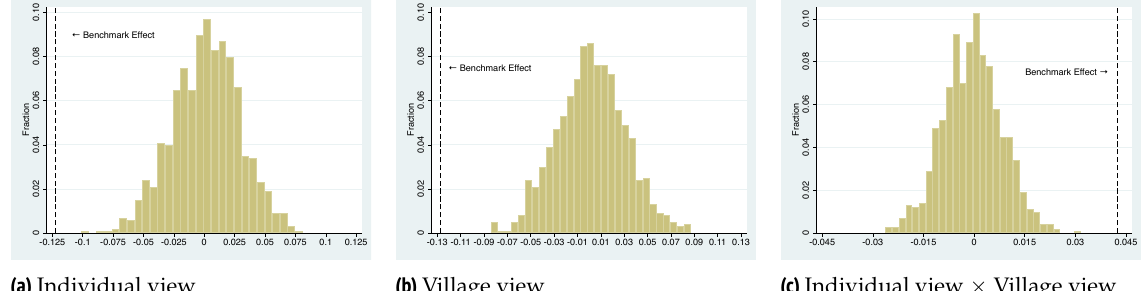
Figure 4: Randomization inference to evaluate robustness of benchmark effect. Notes: We randomly reshuffle the outcome vector (reporting wrongdoing) in our data using a spatial autocorrelation adjusted randomiza- tion inference test ( × 1,000). In (a), we plot the corresponding output for the base term individual view . In (b), we plot the corresponding output for the base term village view . In (c), we plot the corresponding output for the base term individual view × village view . The model specification is equivalent to Table 2, column